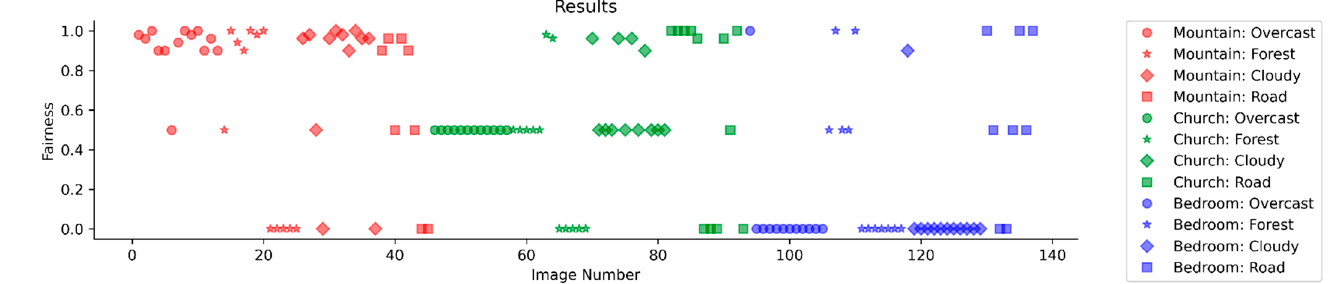
Figure 6. Jain index results of the mountain, church, and bedroom model. From the Jain index results from all the images that were tested, the results that were the closest to 1.0 showed the image had an even distribution of attributes from both patch images from the Flickr dataset and reference images from Google Street View. Results that had a Jain index result of 0.5 or less showed an uneven distribution of attributes from both Flickr and Google Street View. Based on the results, the mountain model created more images with a Jain index closer to 1.0 than the church and bedroom models. In contrast,